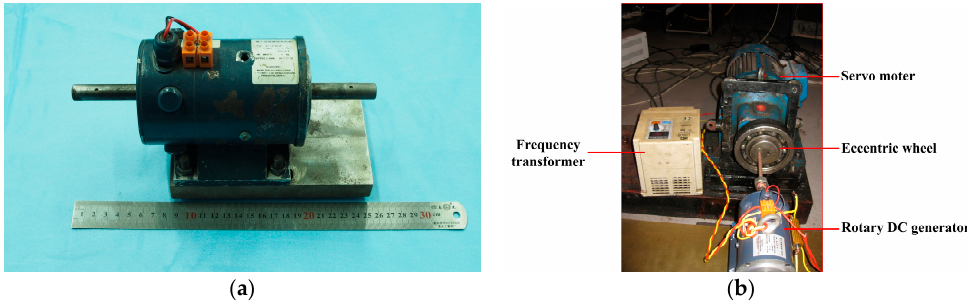
Figure 3. Experimental setup for identifying the back electromotive force constant of the generator.